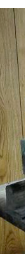
Figure 5. The flexural strength test setup. Figure 4. Specimens placed in the rubber sleeves.